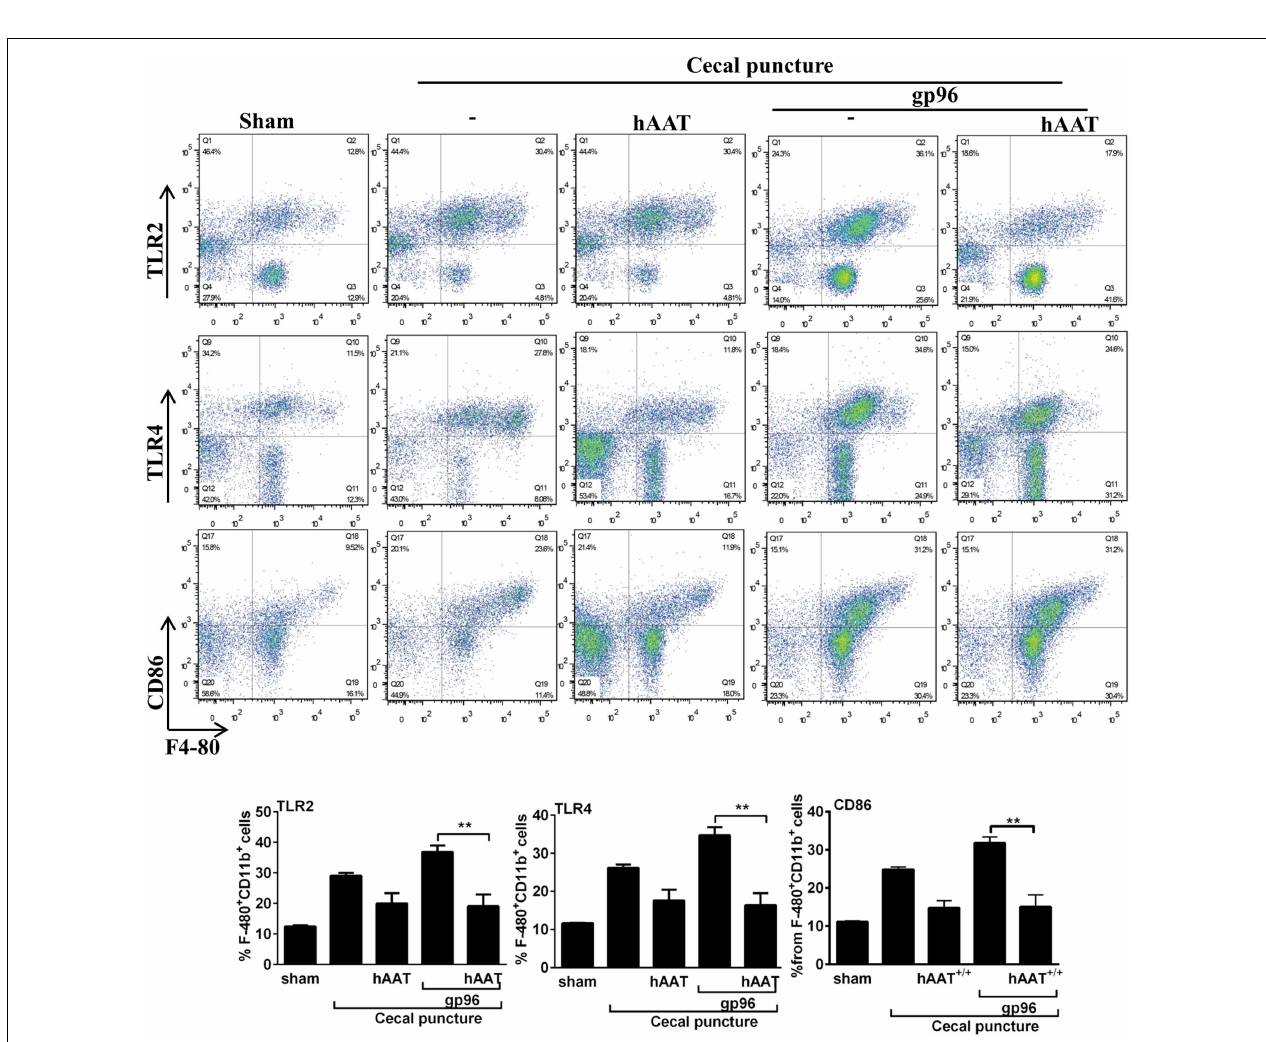
after the surgical procedure). Peritoneal cells were obtained 72 after CP by lavage and immediately stained for surface activation markers. Representative dot plots are shown. Bottom , pooled results. Representative results out of two independent experiments. Mean ± SEM, * p < 0.05, ** p < 0.01, *** p <